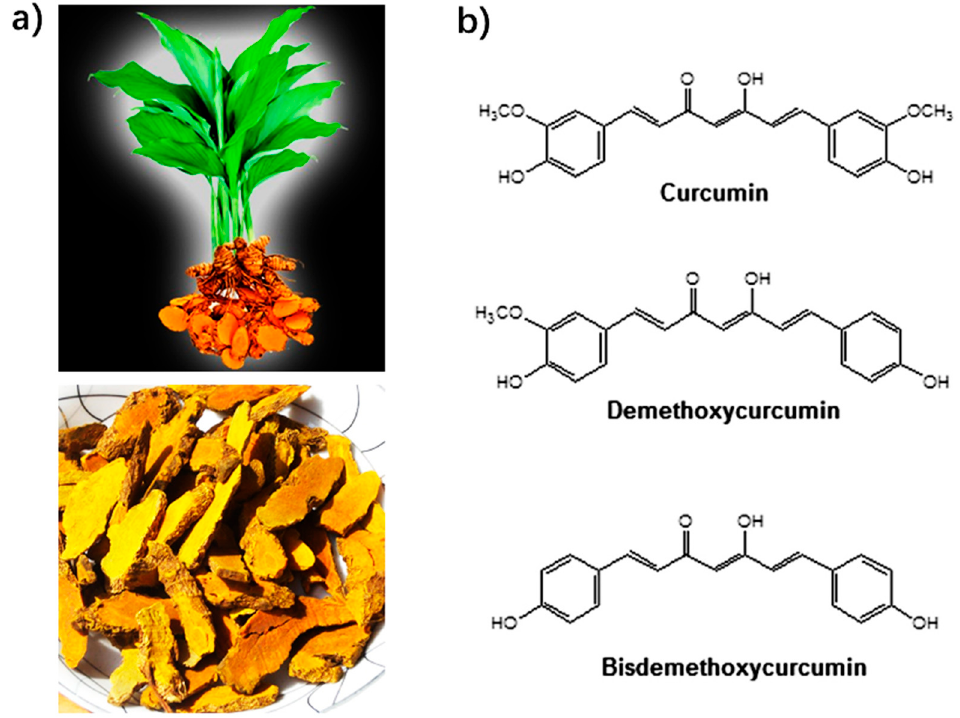
Figure 7. ( a ) Photographs of curcuma longa L. and its dried rhizomes. ( b ) Chemical structure of curcuminoids (curcumin, demethoxycurcumin and disdemethoxycurcumin) from turmeric.